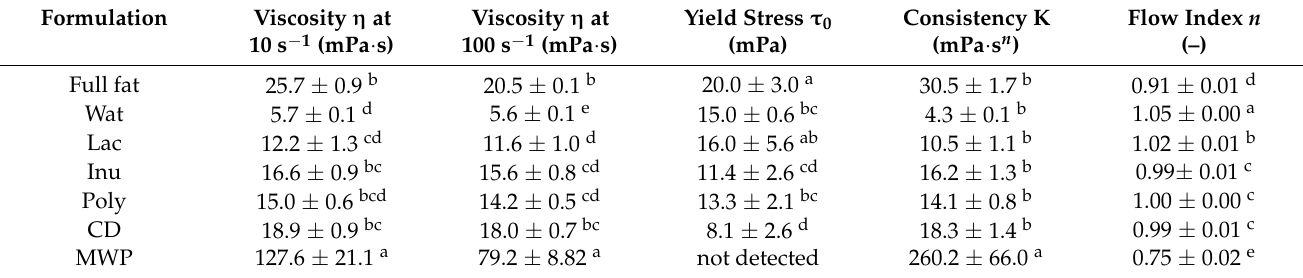
Table 6. Viscosity at a shear rate of 10 s − 1 and 100 s − 1 as well as yield stress, consistency, and flow index (Herschel-Bulkley model) of the rheological characterization of the emulsion